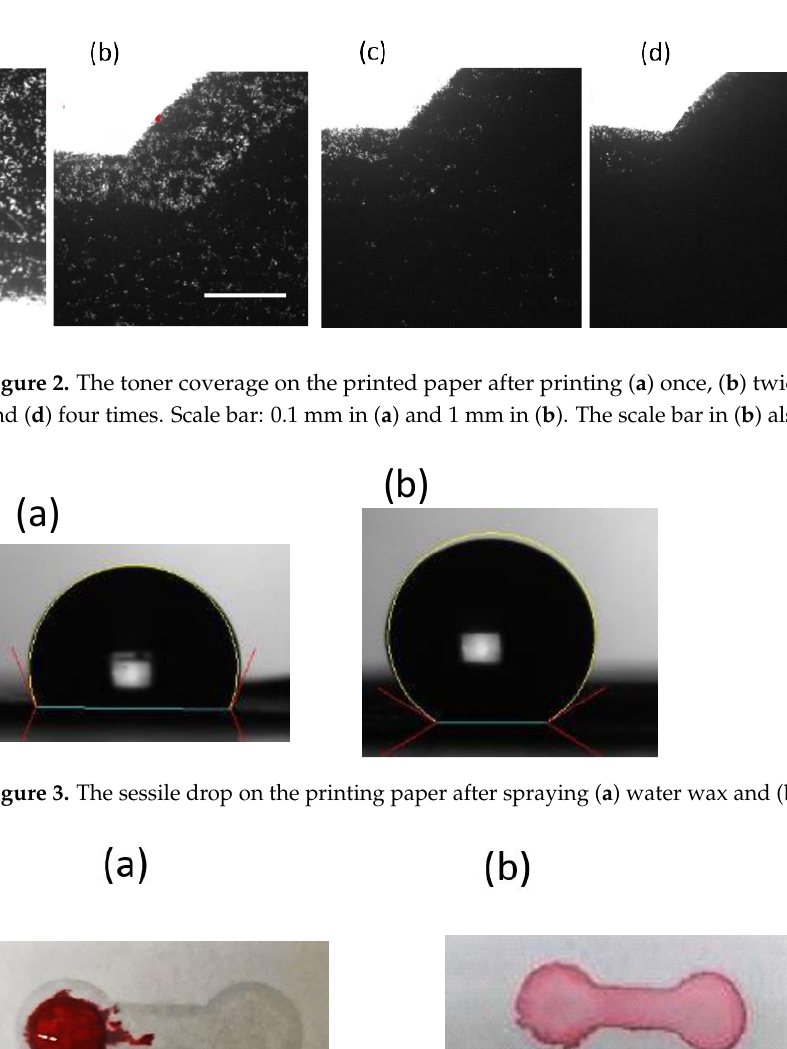
Figure 2. The toner coverage on the printed paper after printing ( a ) once, ( b ) twice, ( c ) three times,